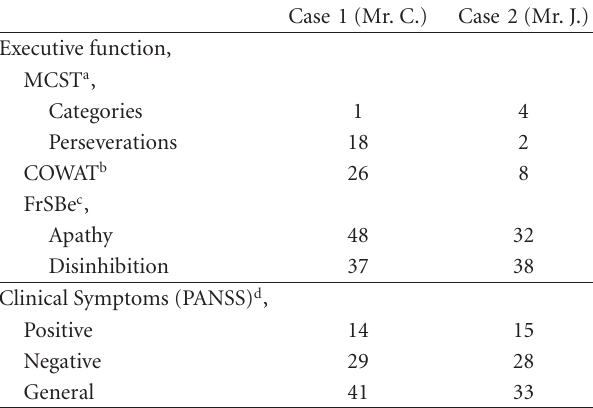
Table 1: Baseline characteristics for the two cases. Case 1 (Mr.